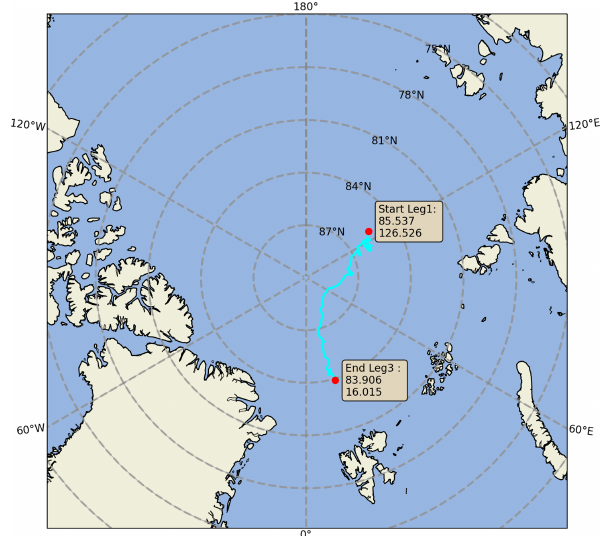
Figure 1. The drift trajectory of RV Polarstern between 24 Octo- ber 2019 and 7 May 2020.